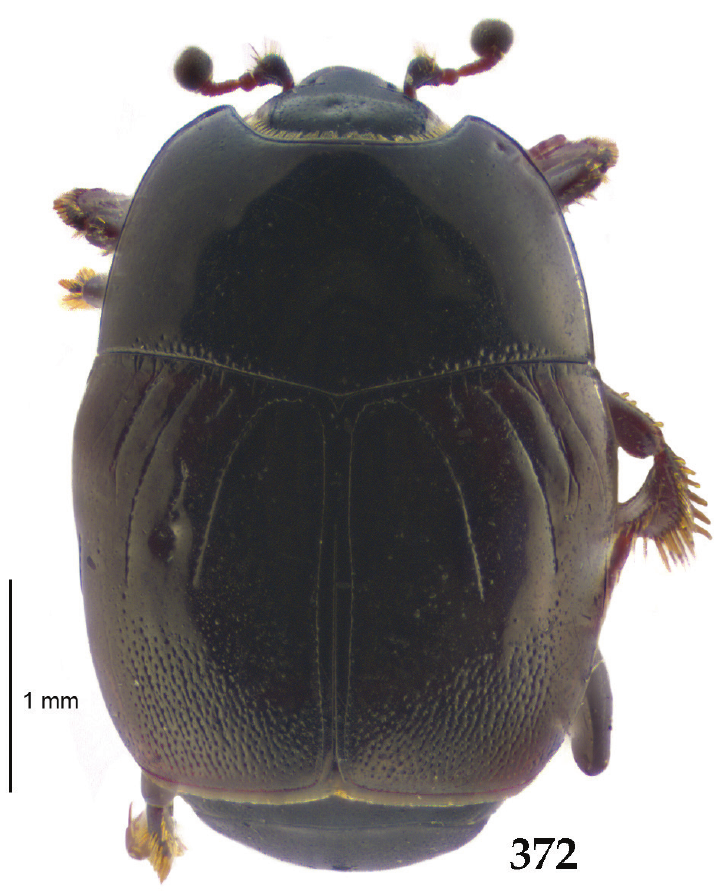
Figure 372. Saprinus ( Saprinus ) chathamensis sp. n. habitus, dorsal view. Biology. Found under rotting pilot whale and under